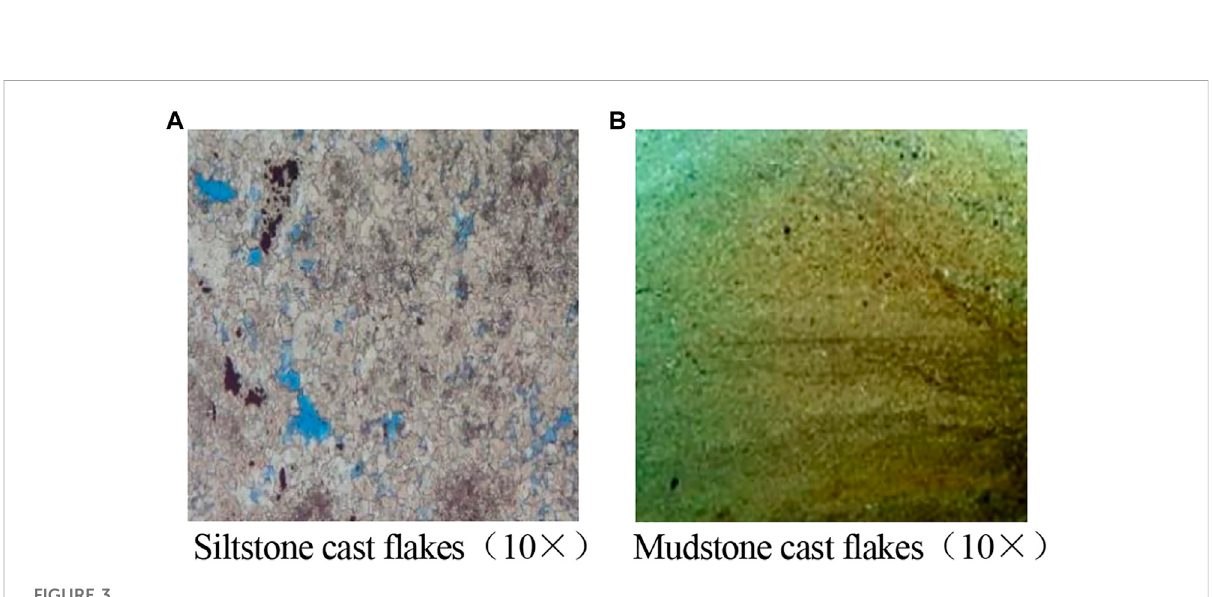
FIGURE 3 Rock cast fl ake of tight oil reservoir in H reservoir of Liaohe oil fi